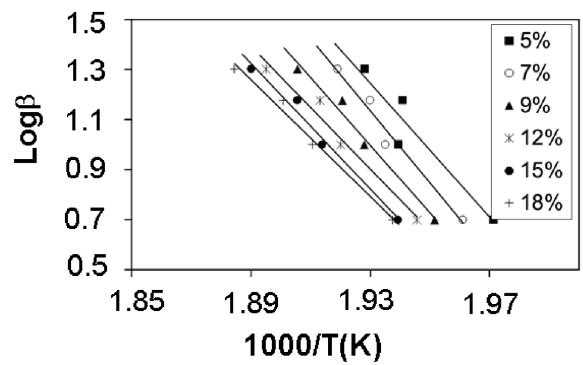
Fig. 5. Typical plots of Log β versus (1000/ T ) for poly(BMKMA)